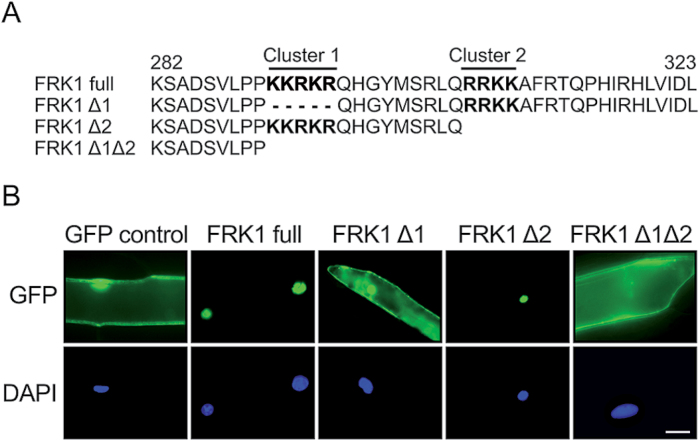
Characterization of the ScFRK1 bipartite nuclear localization signal. (A) Details of the wild type and modified C-terminal region of ScFRK1 constructs used for protein localization studies. The ScFRK1 coding region was fused in-frame to the N-terminus of GFP. The two short basic amino acid sequences predicted to form the NLS are shown in bold. (B) Visualization of GFP expression (top) and DAPI (nucleus) localization (bottom) in bombarded onion cells expressing the fusion constructs. Scale bar=25 µm.